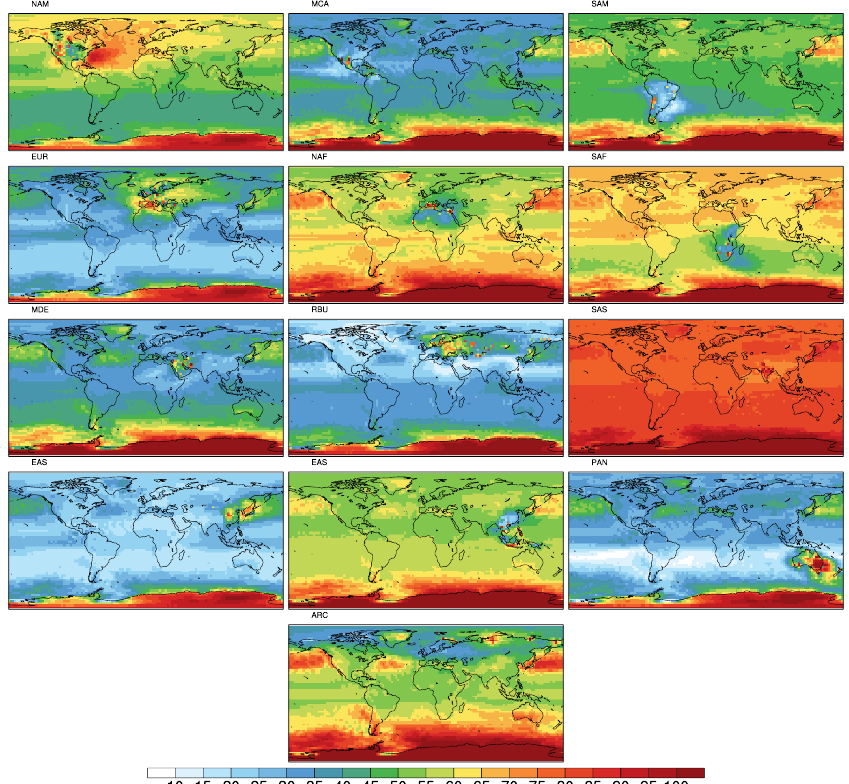
Figure 2. Normalised confidence interval amplitudes for the mean (NCIAM) of the total Hg anthr deposition due to each of the source regions. Amplitudes were normalised by the mean value in each model cell, therefore values greater than 100% correspond to a total uncertainty larger than the mean value itself. Both mean and CI (at the 95% level) were calculated using the bootstrap method [23], starting from the ensemble of simulations reported in Table 1. The results clearly show how the uncertainty on the deposition due to Hg emissions from SAS (South Asia). Uncertainty south anthr